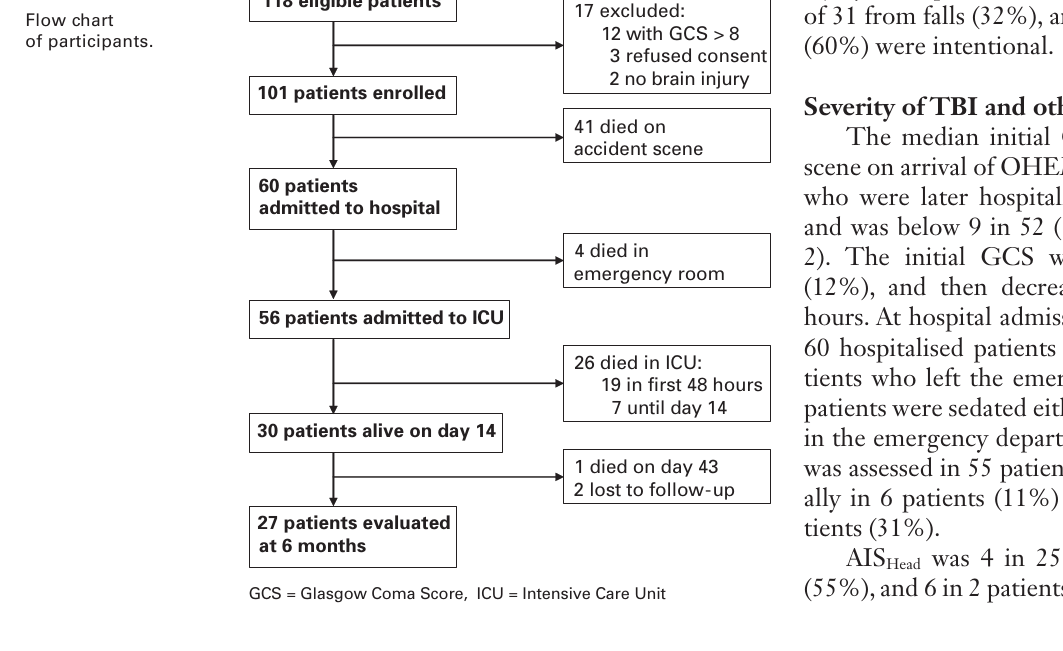
Figure 2 Neurological and functional status of hospitalised